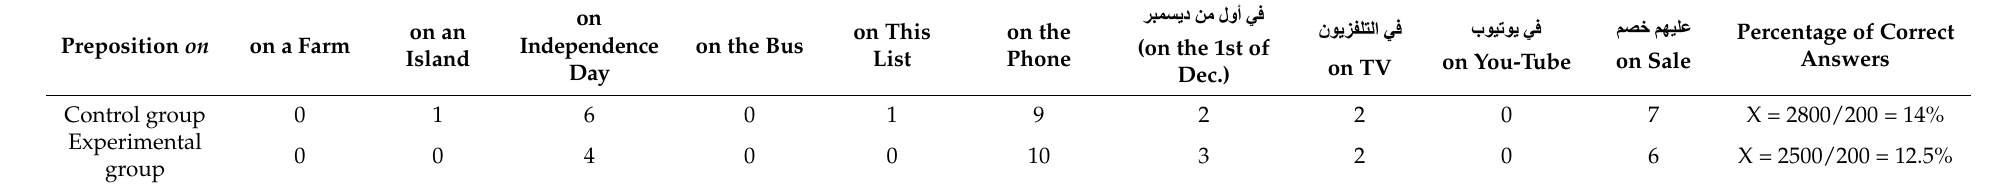
Table 2. Pretest for the preposition on . Table 7. Posttest 1 for the preposition on . Table 7. Posttest 1 for the preposition on . Table 7. Posttest 1 for the preposition on .